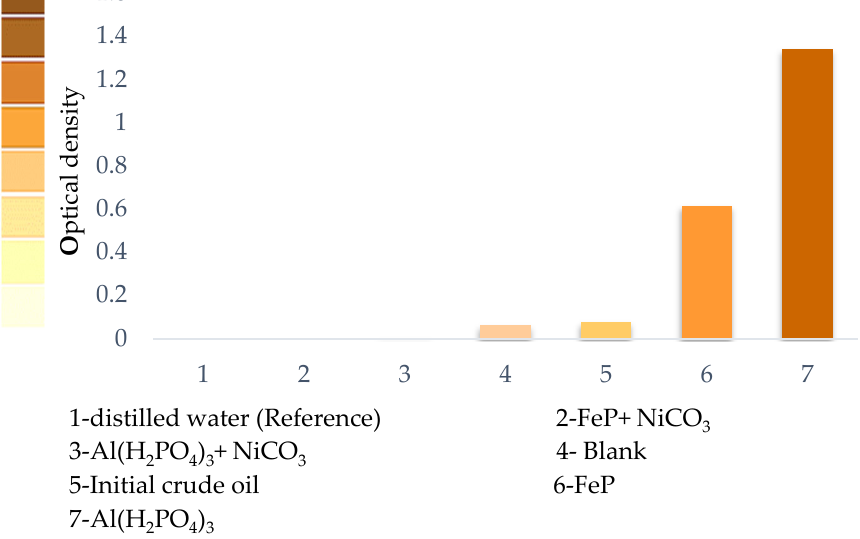
Figure 5. The photo colorimetric analysis results of gasoline fractions before and after the thermolysis of heavy oil samples.